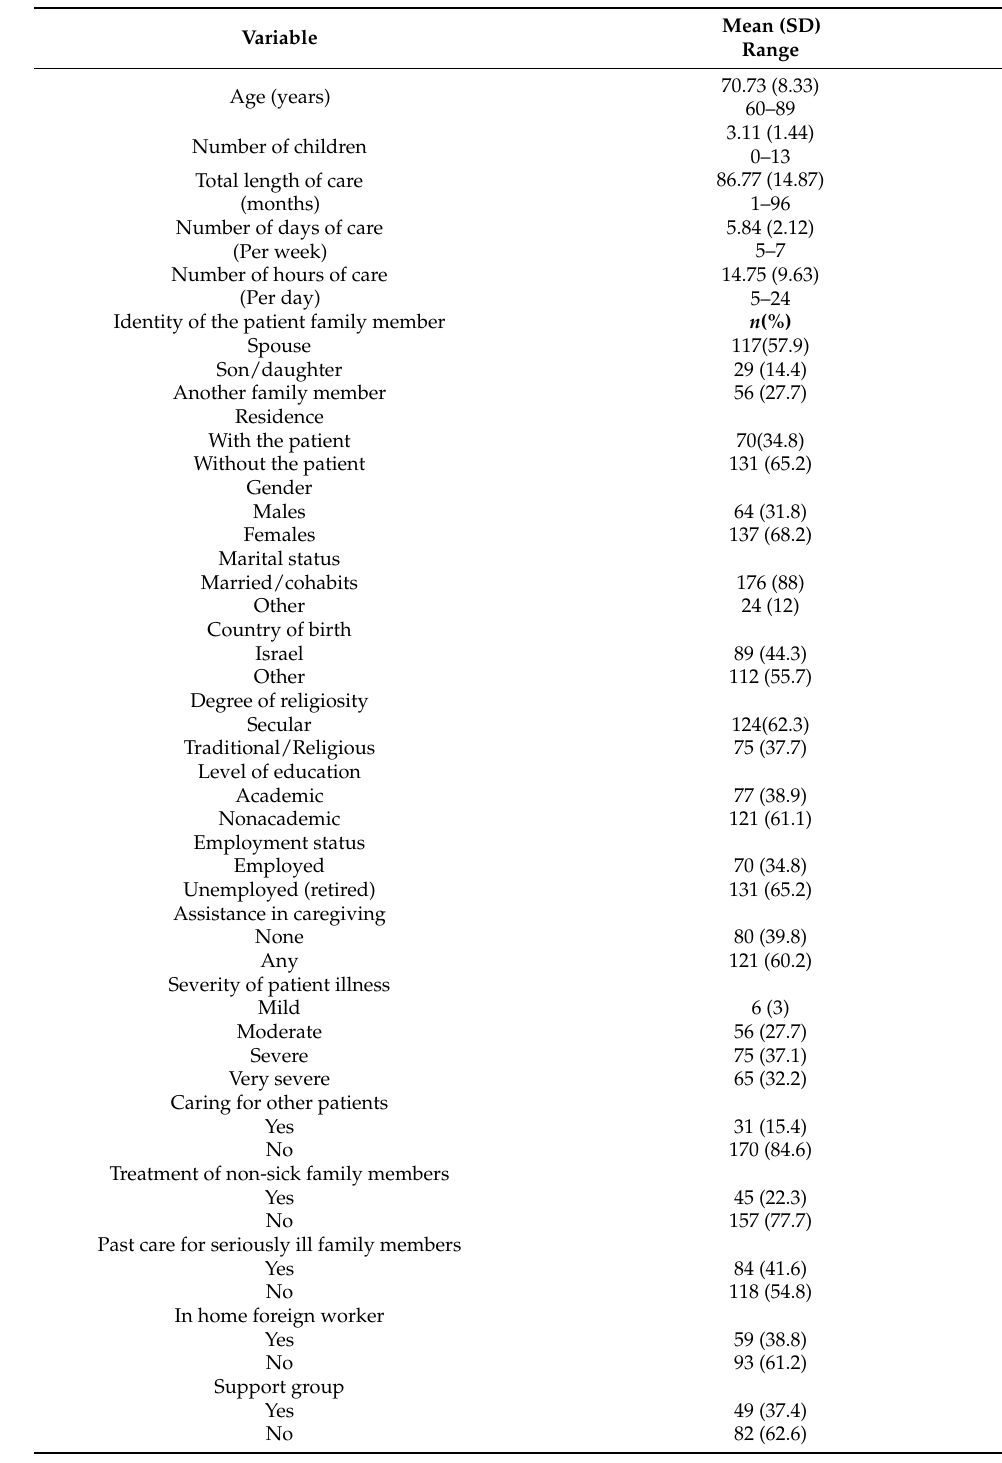
Table 1. Descriptive statistics of caregivers’ sociodemographic characteristics, patient care character- istics, and situational variables ( n =